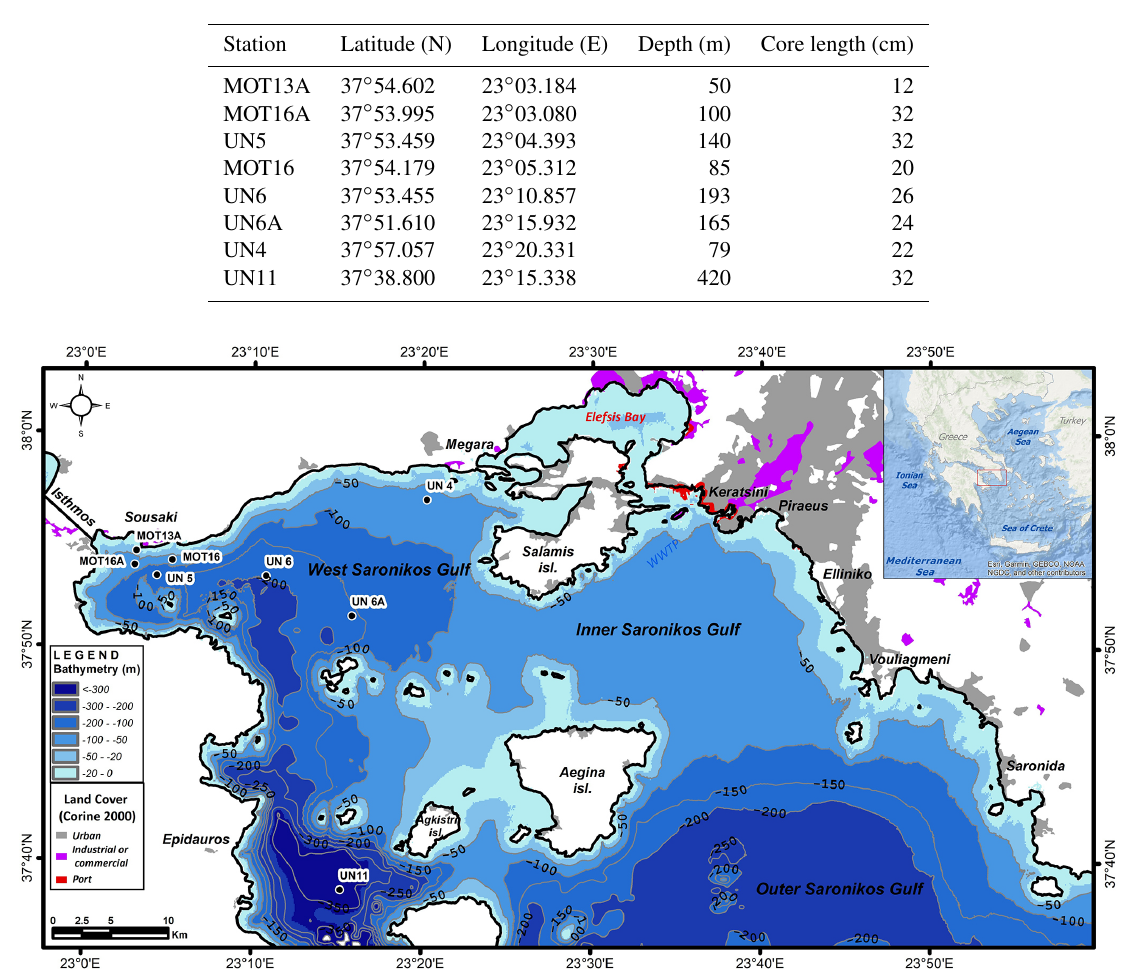
Table 1. Coordinates, water column depths and core lengths at each sampling station.